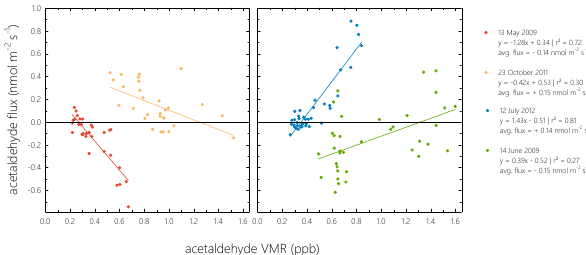
Figure 6. Four days with different relationships between half- hourly acetaldehyde volume mixing ratio (VMR) and flux includ- ing linear regression lines, showing negative and positive correla- tion between the 2 parameters on days with net emission and net deposition of